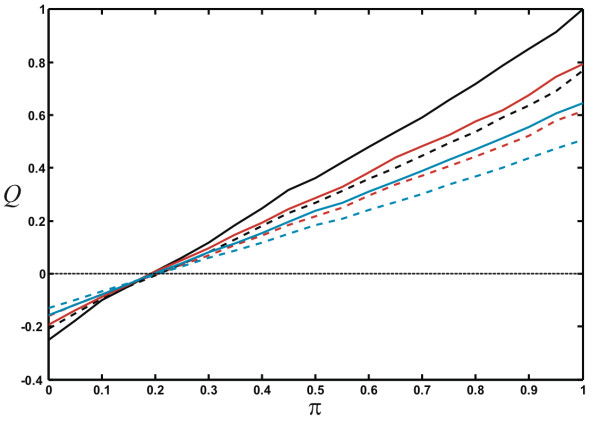
Modularity depends on node-fusion probability. Average modularity (from 50 independent networks with five modules, grown to 1000 nodes) for different node duplication probabilities r = 0.5 (blue), r = 0.75 (red), and r = 1.0 (black), for the modularity measures QN (solid lines) and QH (dashed lines). The networks were grown with the stochastic parameters set to PN = 0.5, PE = 1, p = q = 1.0, PD = 0.2.